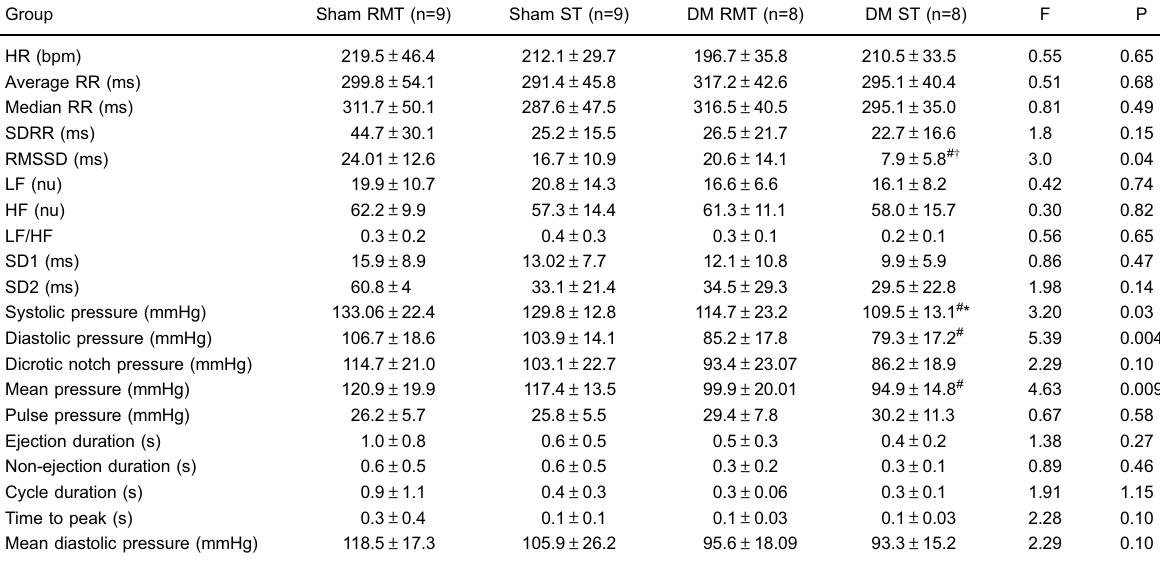
Table 2. Hemodynamic variables derived from the blood pressure records of rats with streptozotocin-induced diabetes mellitus (DM), sedentary (ST) or treated with respiratory muscle training (RMT), and controls (Sham).